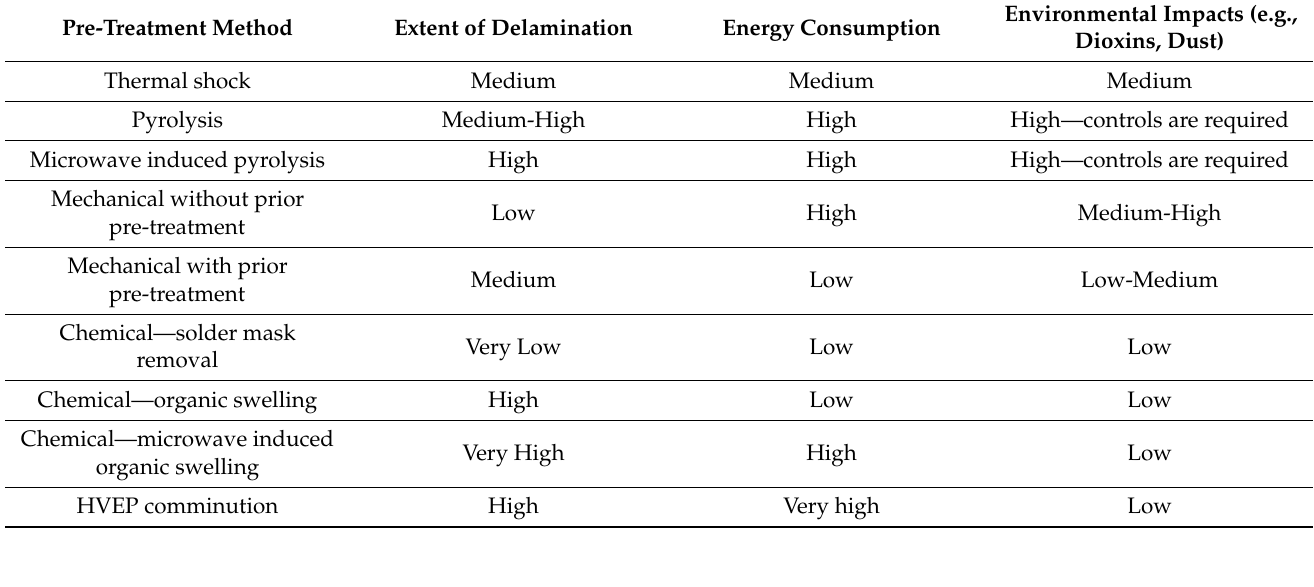
Table 3. Individual qualitative comparison of different coarse PCB pieces pre-treatment methods (Note: quantitative comparison is not performed due to limited data).